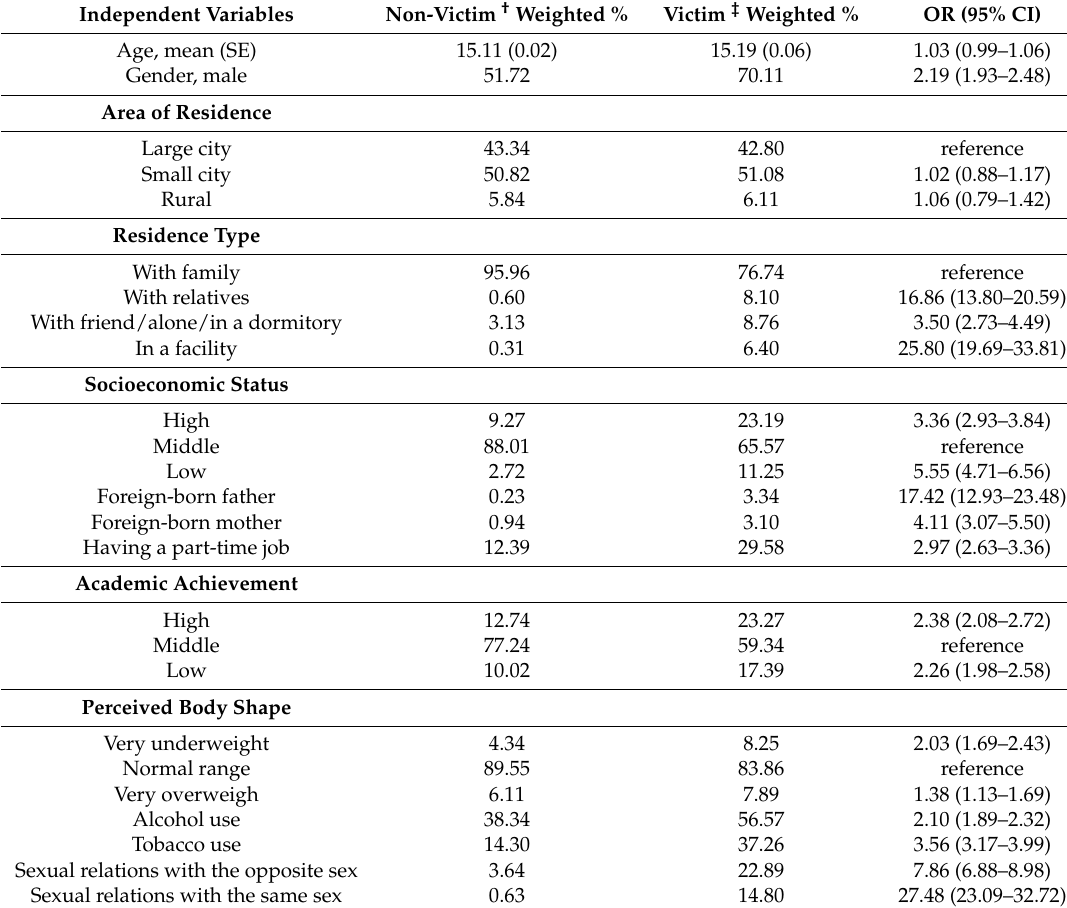
Table 1. Characteristics of violence victims and non-victims among Korean